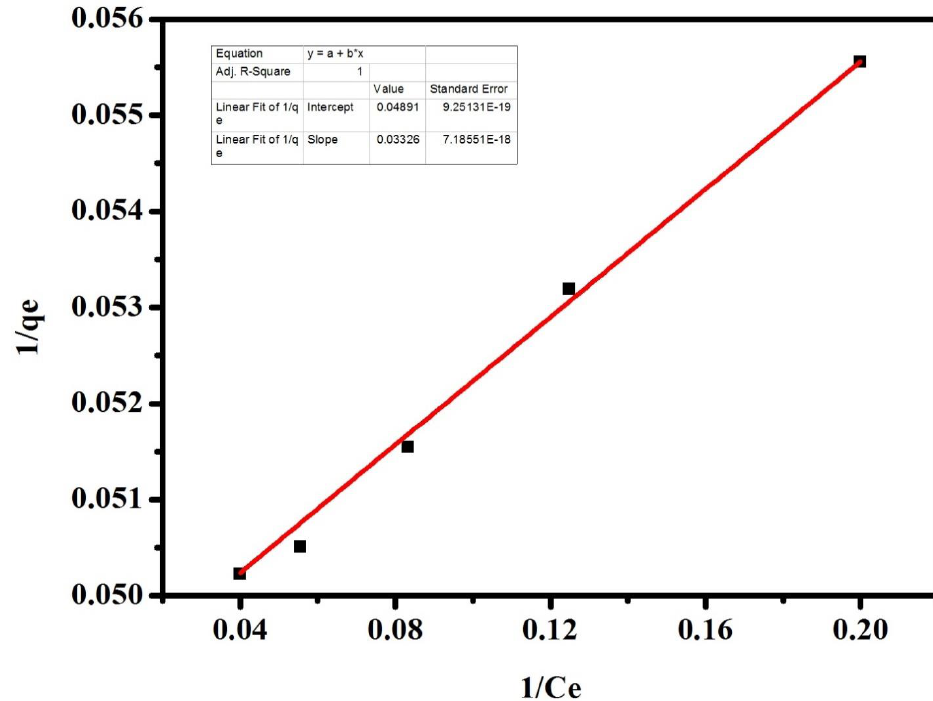
Figure 6. Ba 0.54 Na 0.46 Nb 1.29 W 0.37 O 5 in the Langmuir curve for blue methylene adsorption.